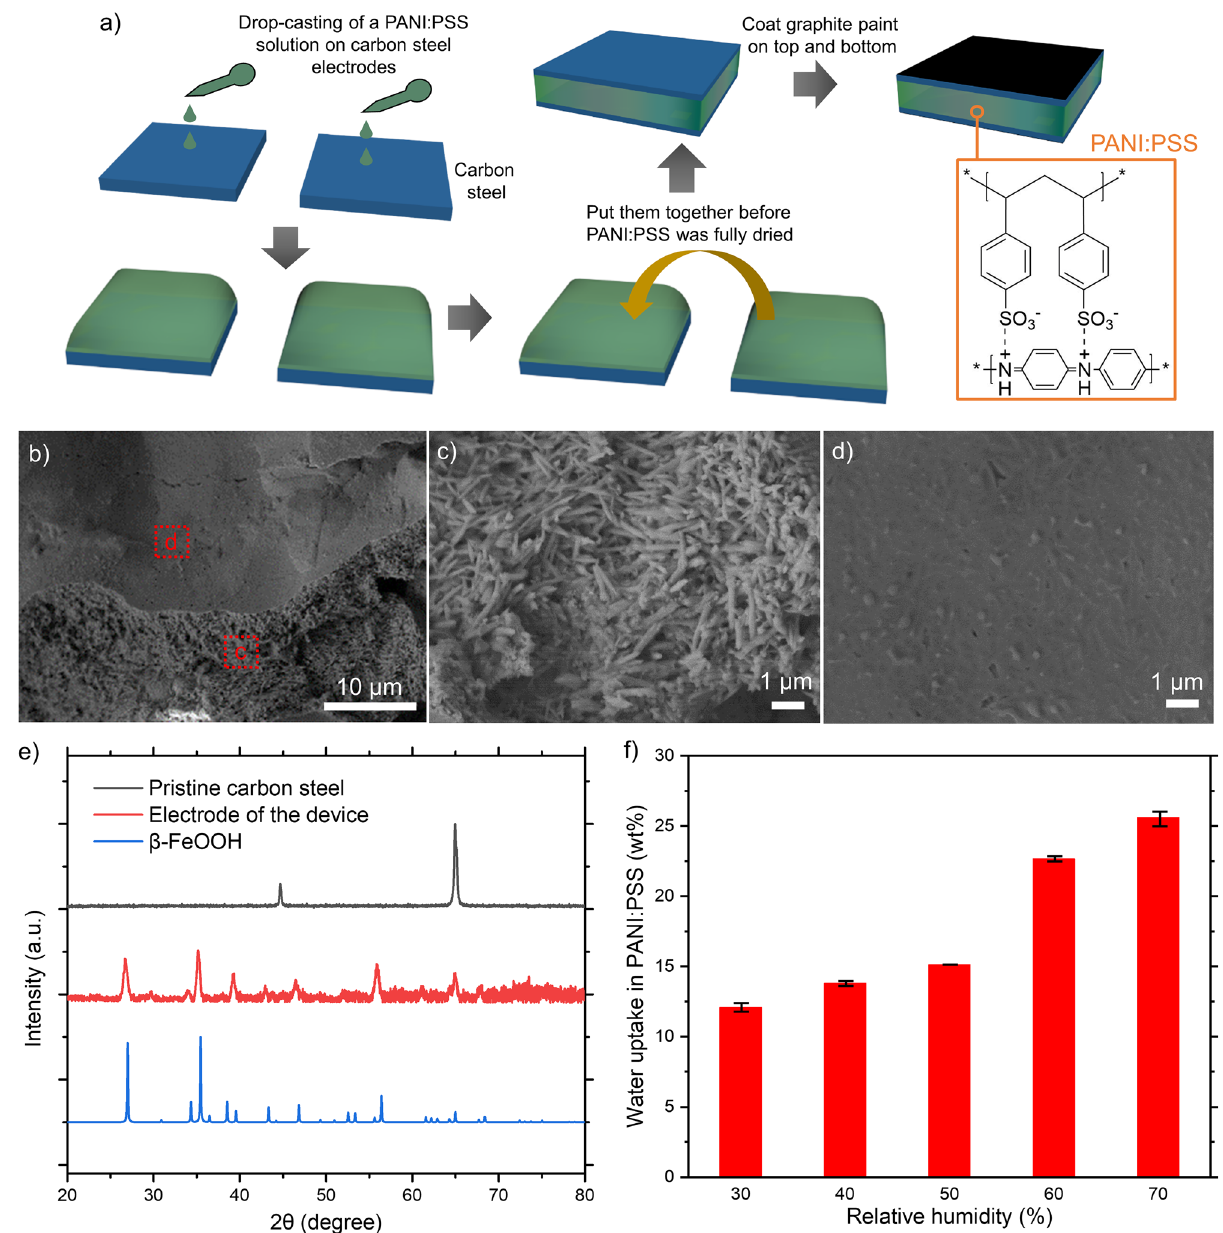
Fig. 1 Device fabrication and characterization. a Device-fabrication procedure. Scanning electron micrographs of ( b ) the carbon steel electrode after detaching PANI:PSS, c a porous area, and ( d ) a fl at area. e X-ray diffraction data for a pristine carbon steel, the electrode shown in “ b ” , and reference data for β -FeOOH 30 . f Water uptake of PANI:PSS after the sample was left under the relative humidity for 8 h. Error bar: one standard